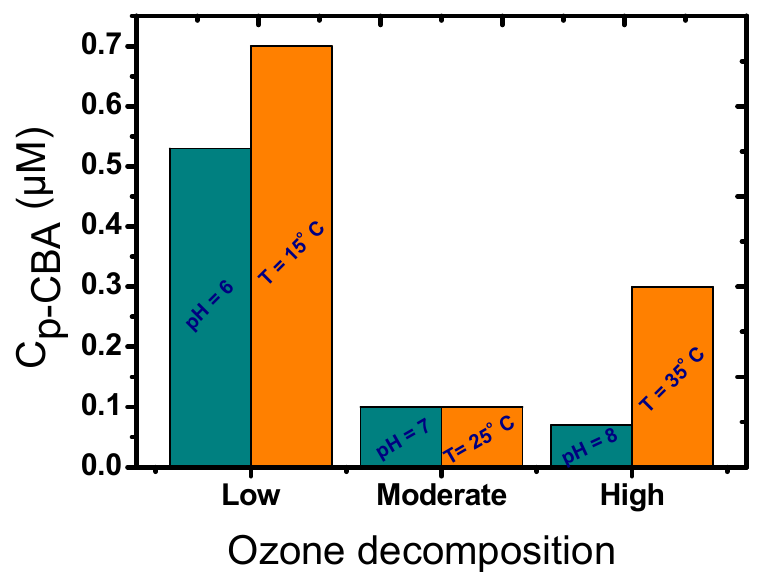
Figure 2. Influence of ozone decomposition rate during the removal of p -CBA, using zeolite-T as a catalyst. Experimental conditions: C p-CBA 4 µ M, C O3 2 mg/L, C zeol. 0.5 g/L, reaction (oxidation) time 1 min.